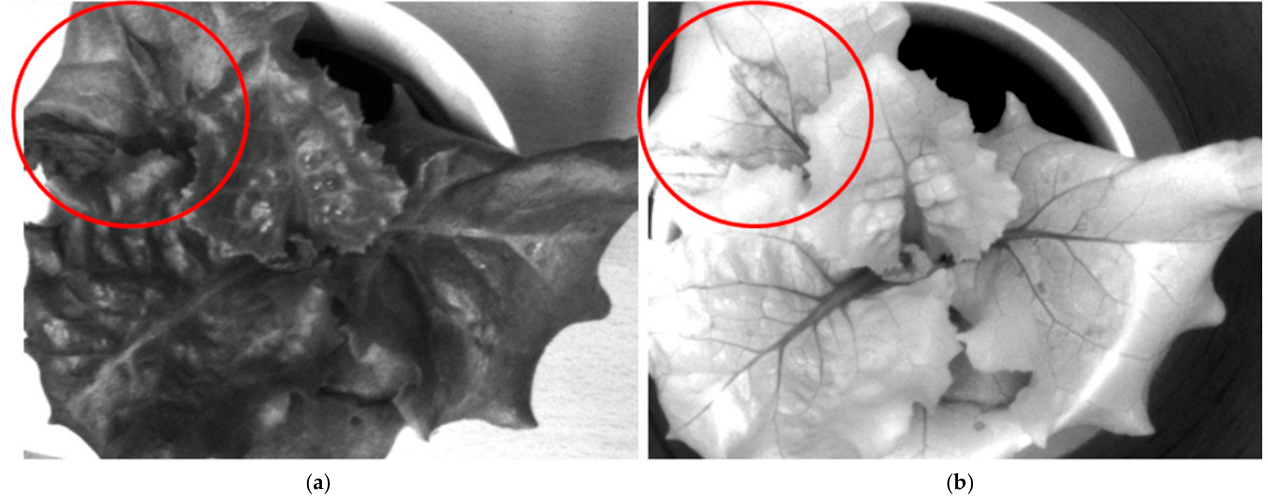
Figure 8. Comparison between general Charged-Coupled Device (CCD) image ( a ) and NIR filter-applied image ( b ).